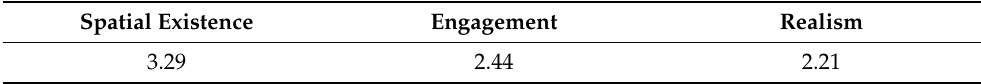
Table 6. IPQ questionnaire